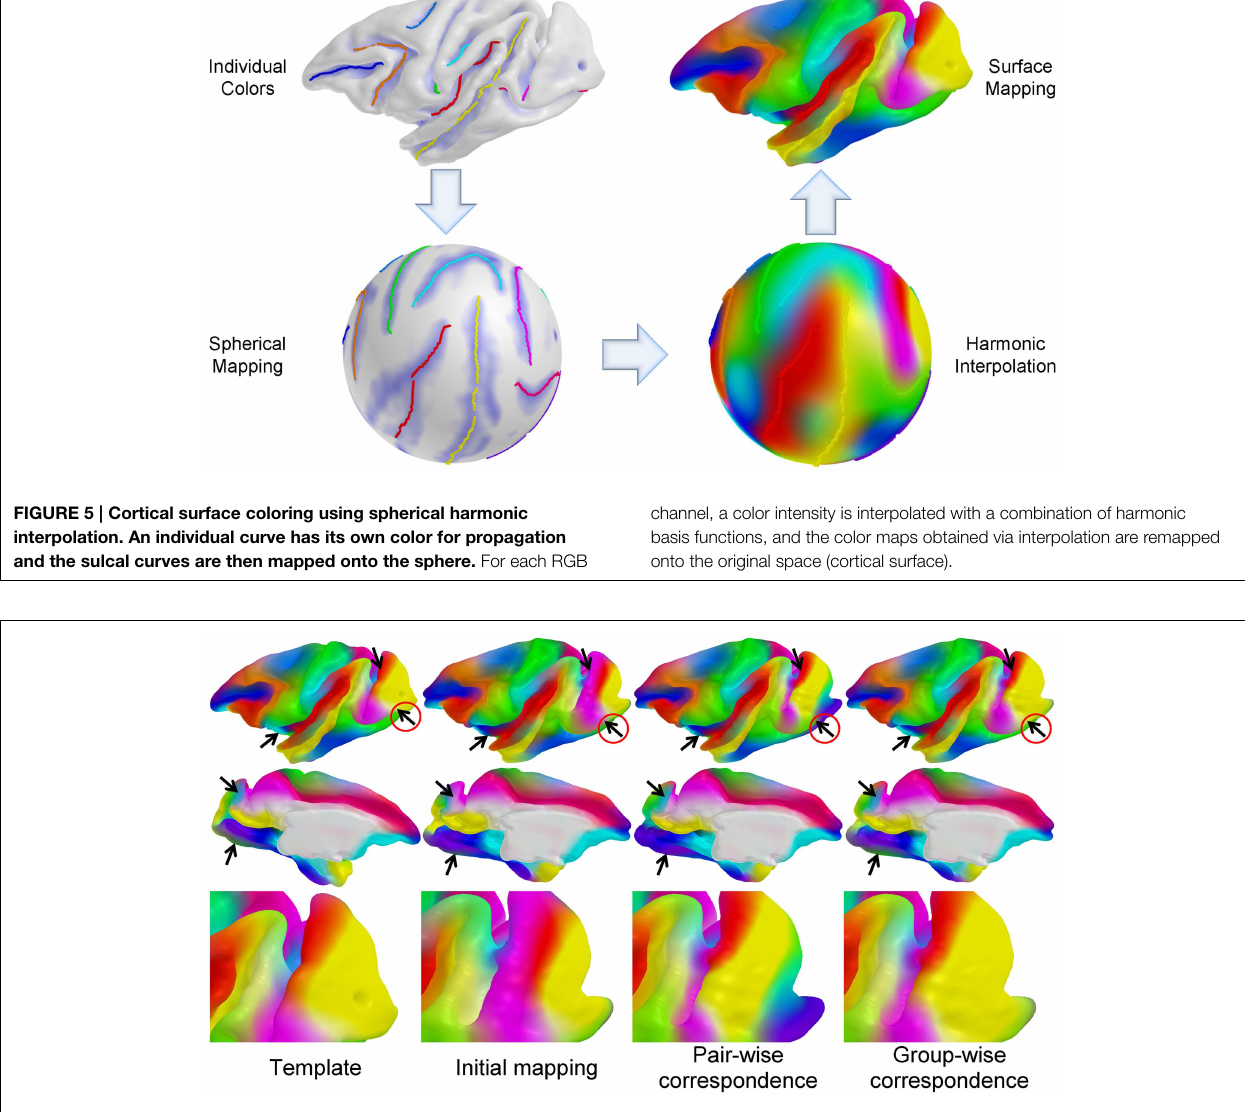
FIGURE 6 | Visual comparison of correspondence results: the colored template surface (first column) is propagated to a selected, representative example surface via initial spherical mapping (second), pair-wise